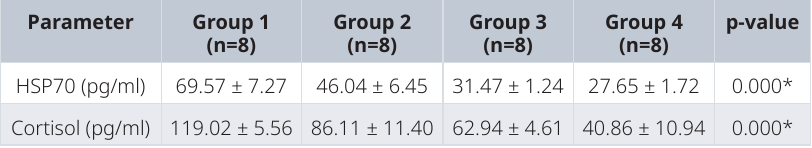
Table 2. Average heat-shock protein (HSP70) and cortisol expression in rats who were subjected to strenuous exercise and treated with distilled water (group 1),